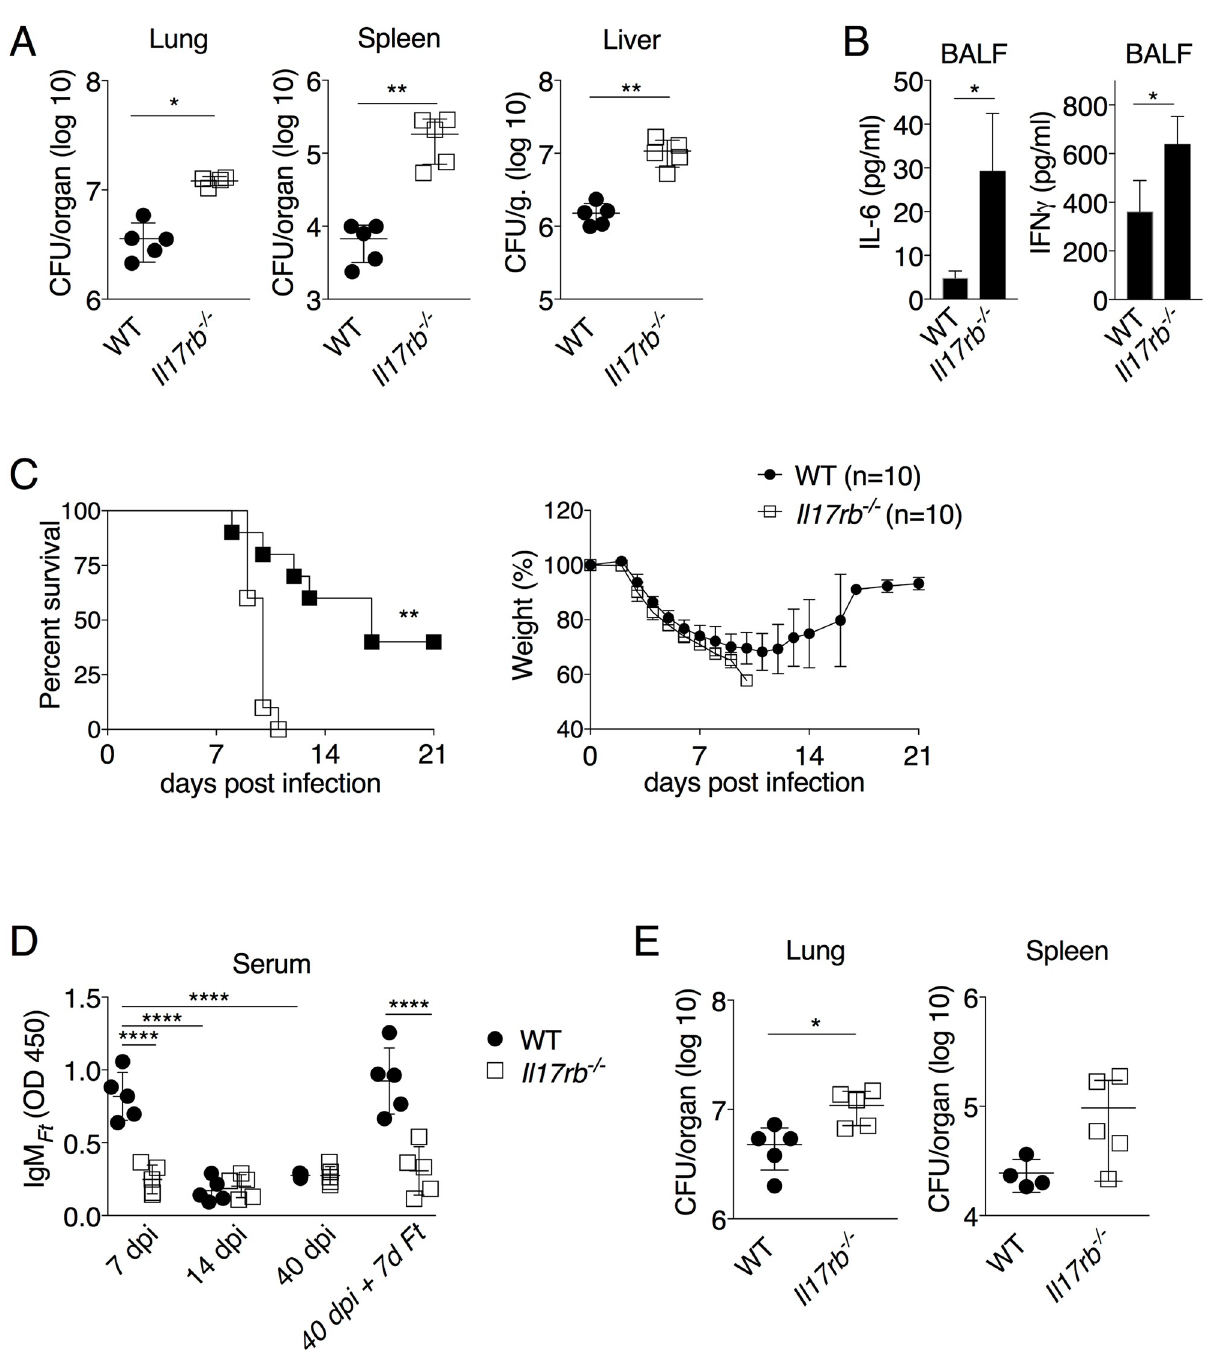
Fig 7. IL17rb -/- mice are more susceptible to Ft infection and fail to develop memory. (A, B) WT B6 or Il17rb -/- mice were infected with Ft (4x10 3 cfu) and bacteria burden in organs and cytokine levels in BALF were measured 7 days p.i. (C) Mice were infected as in A and their survival and body weight were monitored. (D) WT B6 or Il17rb -/- mice were immunized i.n. with LPS Ft and bled at shown time point. On day 40 p.i. mice were infected with Ft (4x10 4 cfu) and euthanized 7 days later to measure IgM and bacteria burden in organs (D). One representative experiment of two. Data are Ft expressed as mean ± SD. A, B, E Mann-Whitney U test; C, Kaplan Meier; D one-way ANOVA Tukey Post-test; E,. � p < 0.05, �� p < 0.01, ���� p < 0.0001.